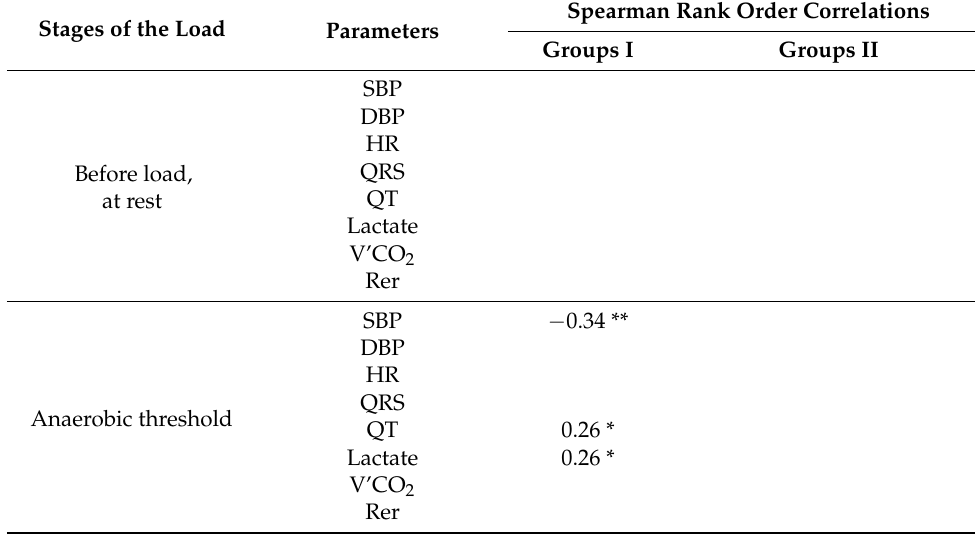
Table 6. Correlations between maximal oxygen uptake and cardiorespiratory parameters and lactate at different stages of cross-country skiers in Groups I and